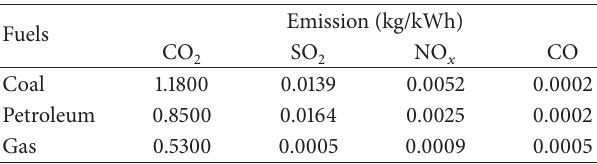
Table 2: The amount of CO production per kWh of electricity